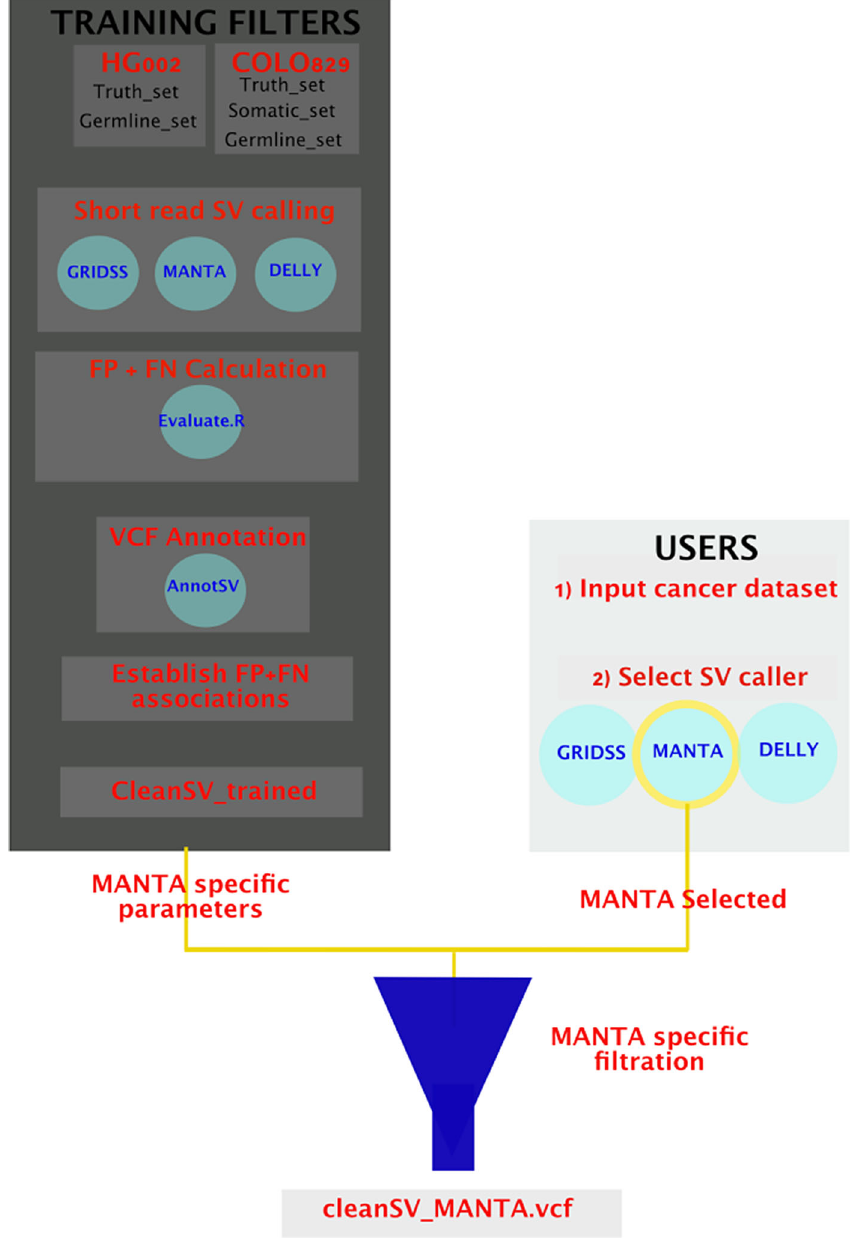
Figure 4. An illustration of the approach used by CleanSV to generate and implement filtration of SV calls. CleanSV pipeline highlighting methods used to generate adequate filters that can be utilised by clinicians to filter false positive and mislabeled SV calls from short-read cancer along with a manually-curated reference set of calls designated as ground truth. The reference set was curated using a paired melanoma and normal lymphoblastoid COLO829 cell lines using four different technologies (Illumina HiSeq, Oxford Nanopore, Pacific Biosciences and 10x Genomics), along with extensive external validation. 47 Using the reference set, we proceeded to investigate the presence and nature of false positives from the initial callsets. (Note that we focused on WGS for this hackathon, but a similar approach could be applied to other assays such as WES.) Samplot 48 visualization of read data allowed manual curation of parameters associated with FP calls, and associations between AnnotSV 48,49 annotated parameters and FPR helped identify additional FP-associated SV parameters (Figure 4). Along with the manually-curated reference set, the panel of normal (PON) used for further filtering was generated from a